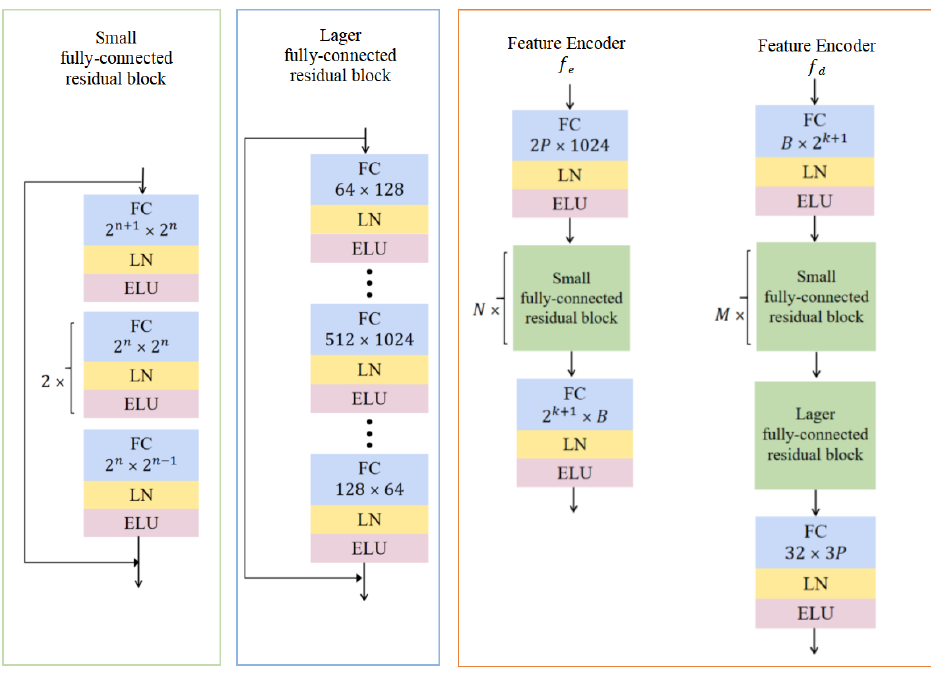
Figure 3. The architecture of the feature encoder f e and feature decoder f d . All neural networks framework increase or decrease exponentially. B is determined by the characteristics of the recon- B , and n ∈ ( 10, k ) . N and M mainly depend on the size of B, and N ∈ [ 2,4 ] structed object, k = log 2 and M ∈ [ 0,3 ]